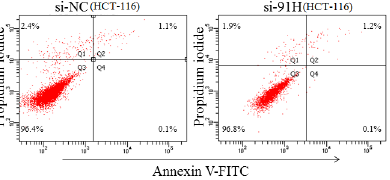
Figure 12. 91H promoted invasion and migration of HCT-116 cells based on transwell assay.